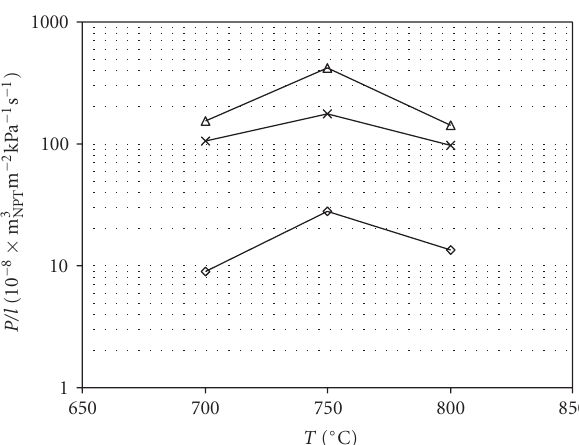
Figure 6: Permeation data of carbon membranes prepared up to 700, 750, and 800 ◦ C: (cid:3) —N 2 , x—He, (cid:2) —CO 2